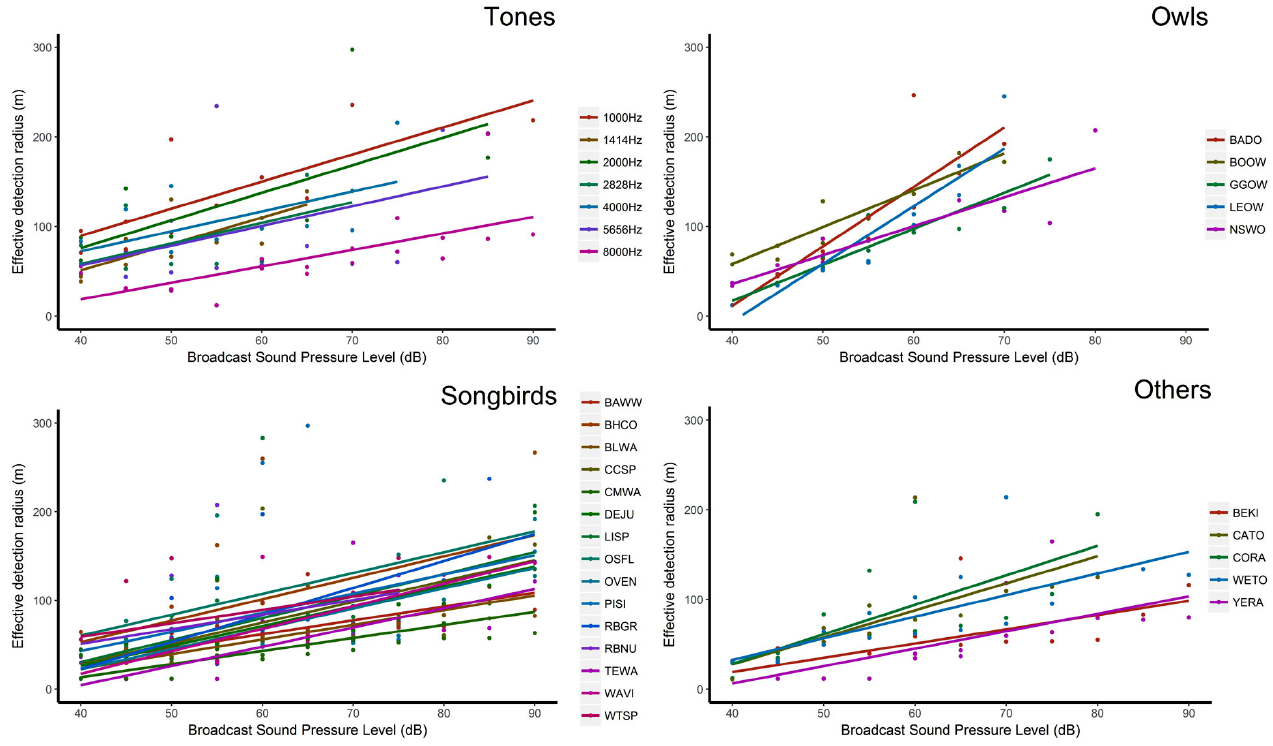
Fig. 3 . Influence of the sound pressure level (dB) of our song broadcasts on EDR for tones, owls, songbirds, and all other species, plotted separately. We found no statistically significant interaction between different species/tones although EDR for two species of owl (GGOW and LEOW) appear to increase at a greater rate with distance than other